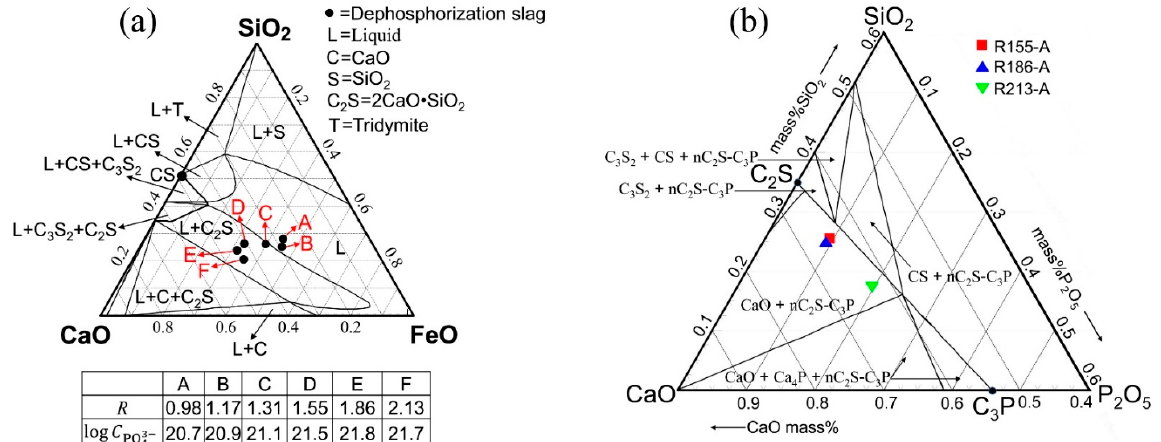
Figure 4. ( a ) Compositions of dephosphorization slags located in the CaO-SiO 2 -FeO ternary phase diagram; ( b ) compositions of the corresponding P-rich phases located in the CaO-SiO 2 -P 2 O 5 ternary phase diagram.